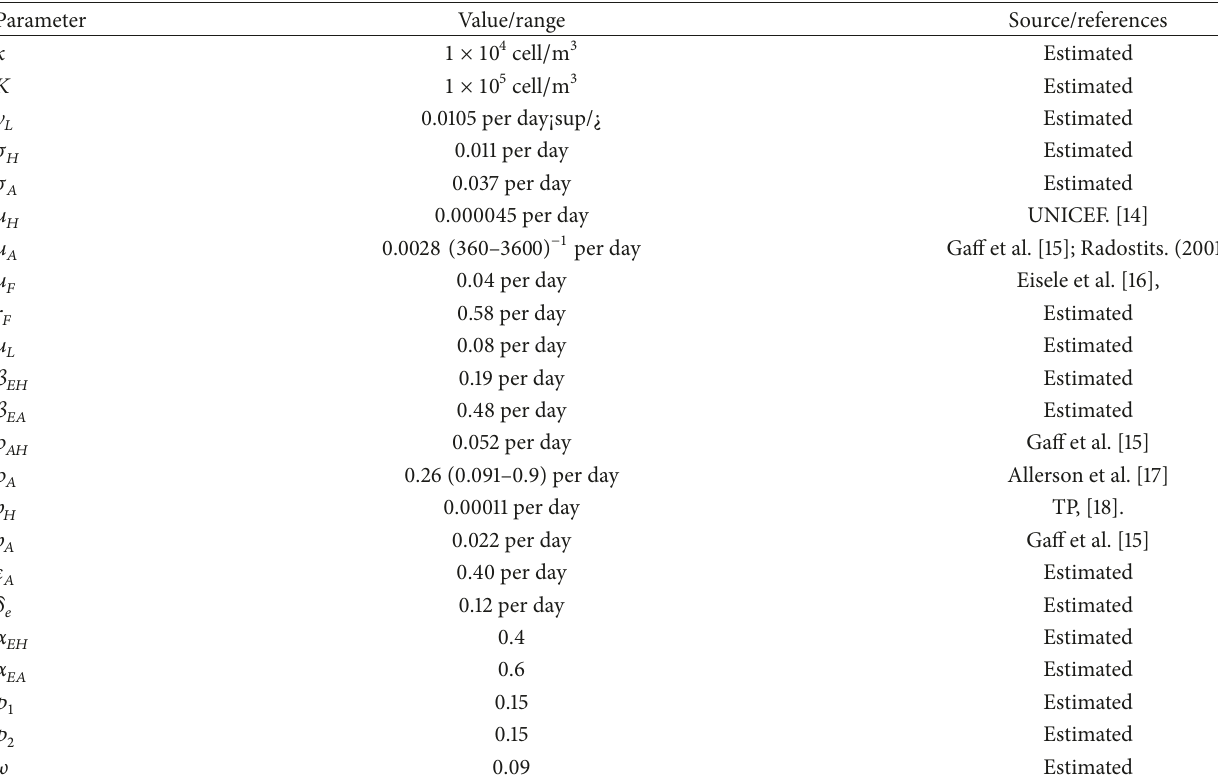
Table 1: Parameter values for numerical simulation of optimal control